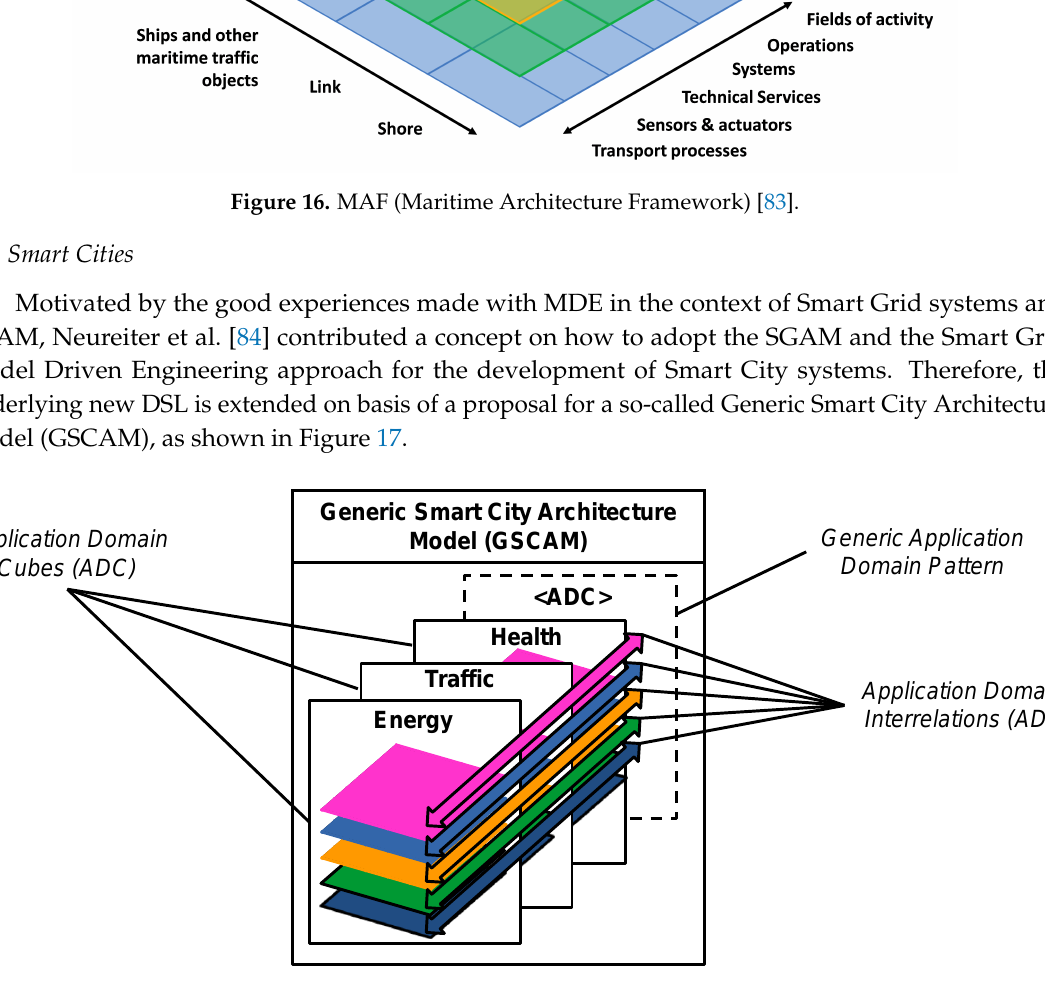
Figure 17. Overview of the Generic Smart Cities Architecture Model